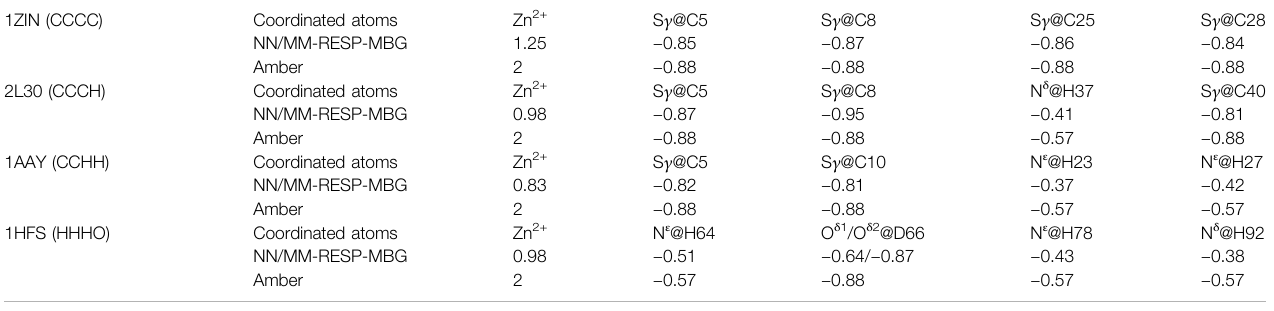
TABLE 2 | The averaged RESP charge of zinc ion and its ligated atoms in the MD simulation. The unit of charge is e .